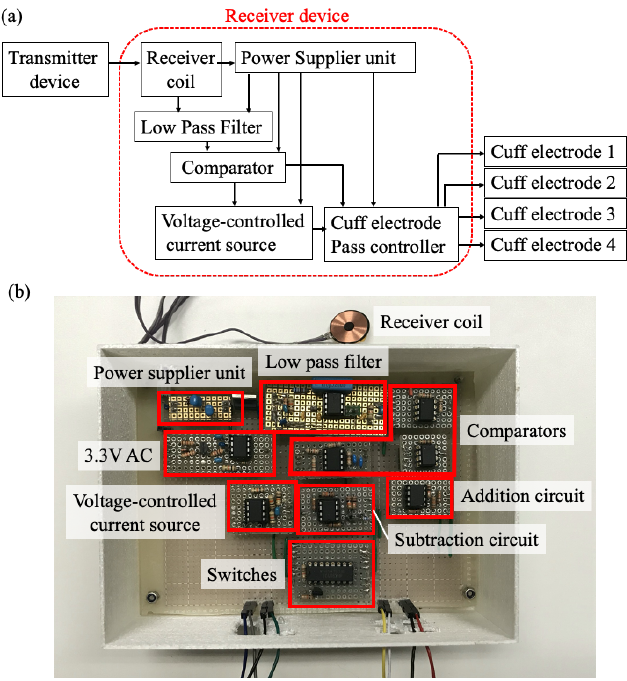
Figure 4. A receiver device for a wirelessly powered four-channel neurostimulator. ( a ) A schematic of the receiver device system; ( b ) the fabricated receiver